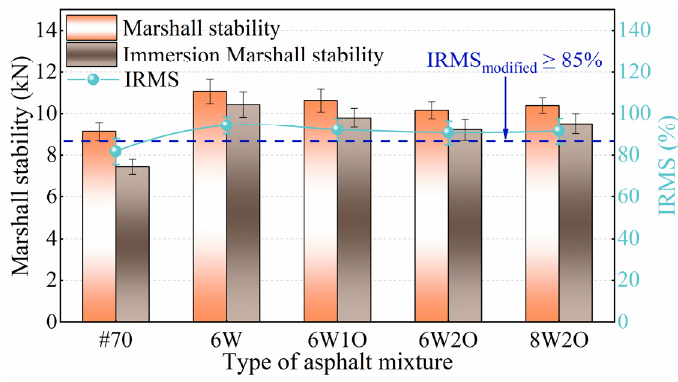
Figure 8. Test results of immersion Marshall stability.